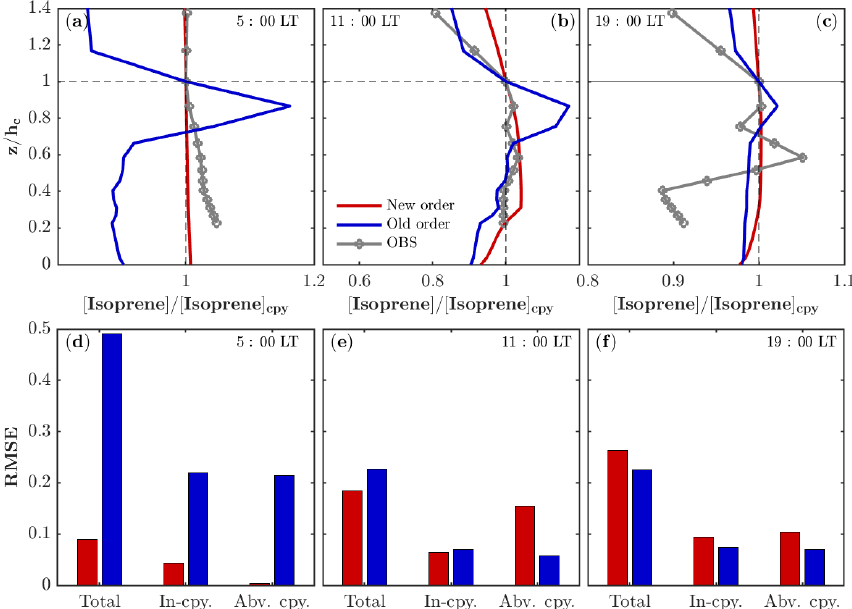
Figure 1. Impacts of operator splitting on the vertical distribution of isoprene. The modeled and observed isoprene vertical profiles (normal- ized by the concentration at the canopy) in the morning (a) , midday (b) , and evening (c) on 22 July 2016. Note that the observed isoprene at 34, 21, 17, 13, 9, and 5m is interpolated into model levels for comparison. The corresponding root mean square error (RMSE) of the modeled isoprene profiles compared to the observations for the morning (d) , midday (e) , and evening (f) on 22 July 2016. The RMSEs are also calculated separately in the canopy (In-cpy) and above the canopy (Abv. cpy).